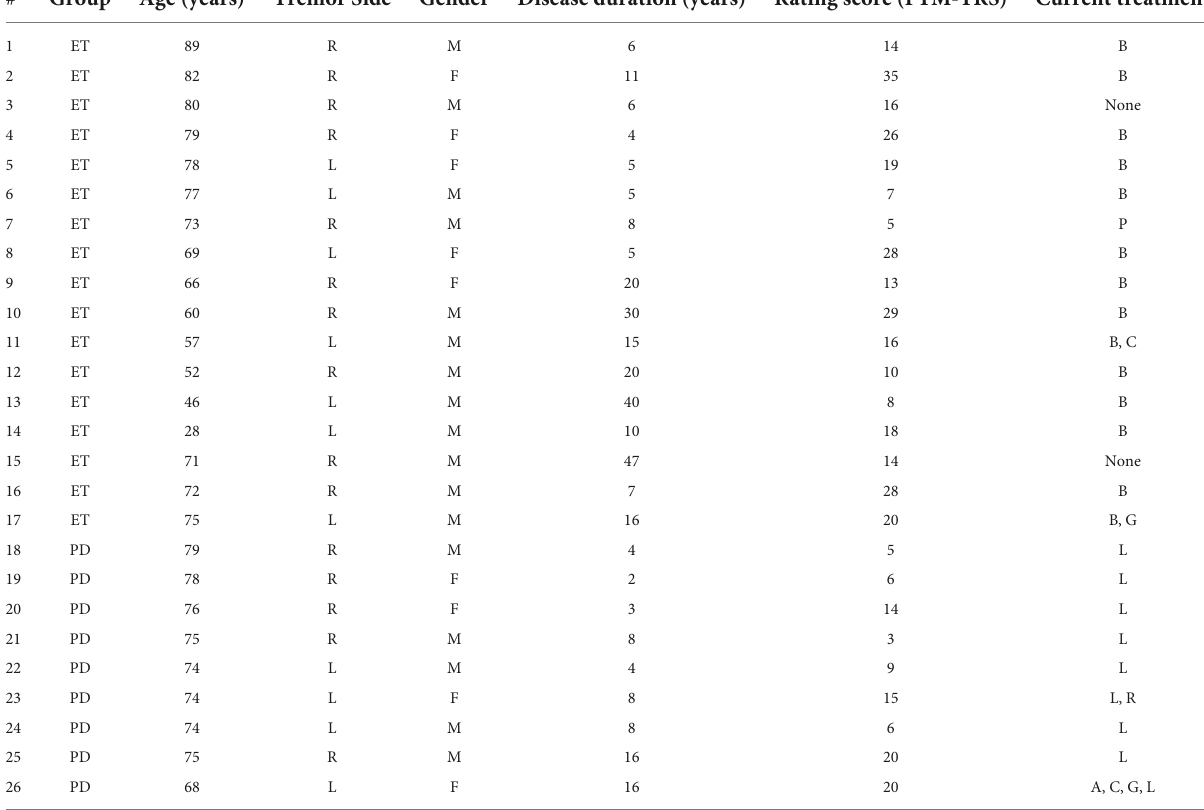
TABLE 1 Clinical profile of subjects with essential tremor and Parkinson’s disease. # Group Age (years) Tremor Side Gender Disease duration (years) Rating score